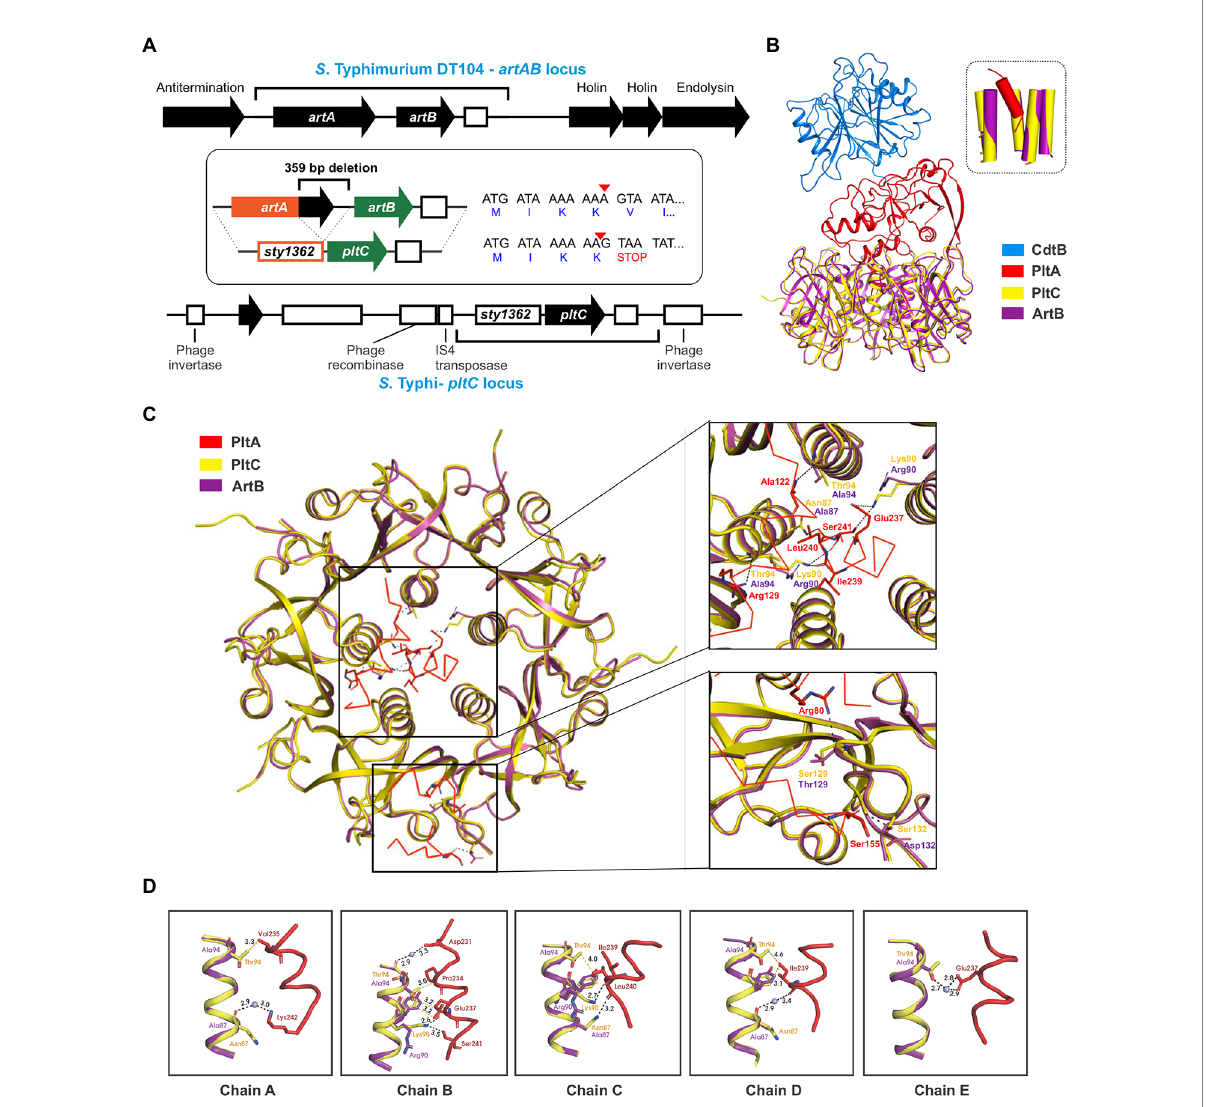
FIGURE 2 Evolutionary divergence of the pltC and artB genetic elements. (A) Comparison of the S . Typhimurium DT104 artAB and S . Typhi pltC genomic loci. The homologous region shared by these two loci is shown using black brackets and this region is further dissected in the inset. The inset highlights key differences between these loci, which includes a 359 bp deletion in the pltC locus, and a single base deletion (red arrow head) in the artA pseudogene sty1362 that results in a premature stop codon after only 4 amino acids. Intact genes are shown as black arrows and pseudogenes as white boxes. (B) Ribbon diagram showing the structure of PltC typhoid toxin (PDB ID: 7EE6) overlaid with the structure of the modelled typhoid toxin that features ArtB (PDB ID: 5WHU) in place of PltC. The inset shows the very similar structures of the central pores of the B subunit homopentamers of PltC and ArtB and the orientation of the PltA C-terminal helix within these pores. (C) Cut-away top-down view of the A-B interactions in the structures described for (B) featuring detailed views of key intermolecular interactions within the B subunit pore and on the apical surface of the B subunit homopentamer. (D) Ribbon diagram of the structures described for (B) showing the interactions involving the PltC residues Asn87, Lys90 and Thr94 with the C-terminal helix of PltA, and the absence of many of these interactions in the modelled ArtB structure. Boxes show the individual PltC/ArtB chains that make up the